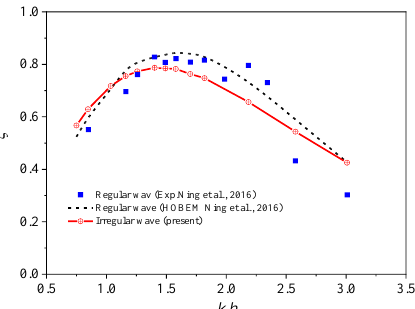
Figure 10. Comparison of the hydrodynamic conversion efficiency versus peak wavenumber be- tween regular and irregular wave conditions.